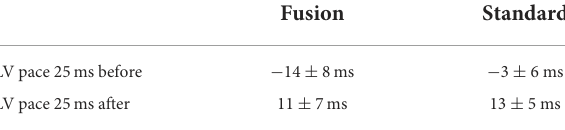
TABLE 3 The simultaneous (SIM) pacing group subdivided into within 25ms before or after RV